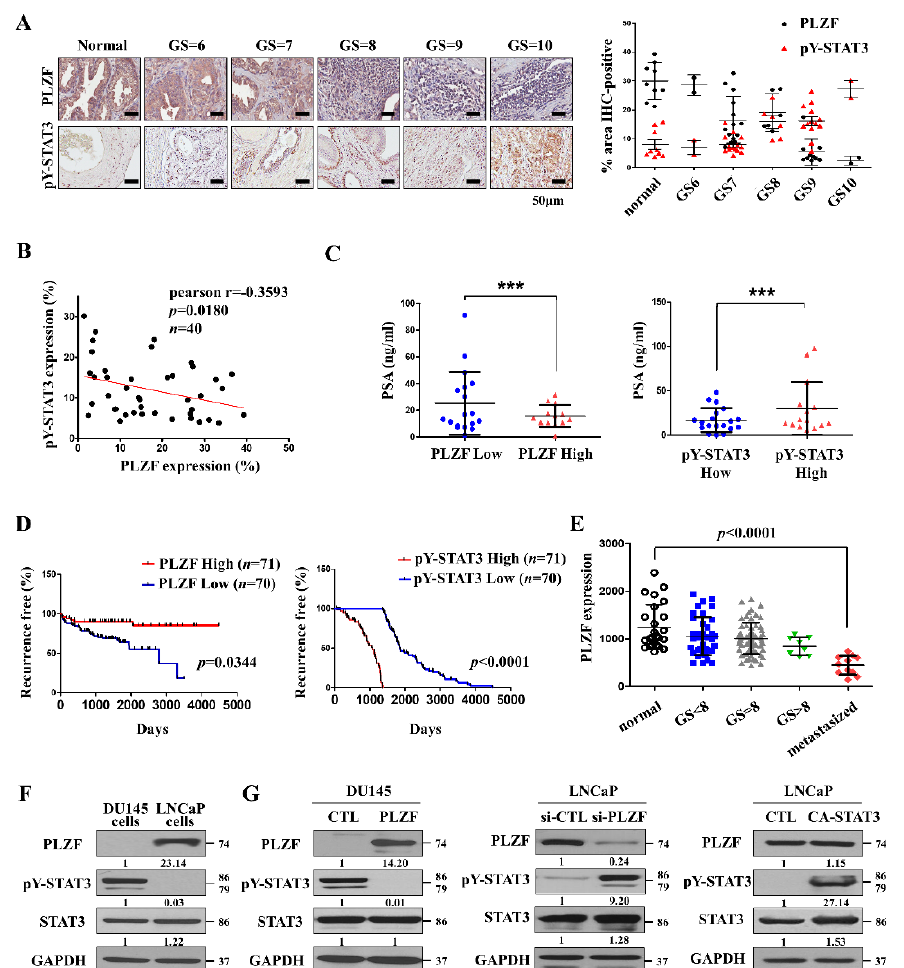
Figure 1. Promyelocytic leukemia zinc finger (PLZF) inhibits the activation of STAT3, which has an inverse correlation with PLZF. ( A ) IHC of PLZF, pY-STAT3 in tissue arrays of surrounding normal prostate tissues, and human prostate cancer specimens correlates with Gleason scores (GS). Quantification of PLZF-positive expression according to the GS in normal tissues adjacent to the benign tumors ( n = 9) and malignant tumors ( n = 40) (right). ( B ) Associations between expression of PLZF and pY-STAT3. Scatter plots showing the linear correlation determined by Pearson correlation coe ffi cient calculation of those genes that were statistically significant. Pearson correlation coe ffi cient r and p -values are given in each scatter plot. ( C ) PSA levels were measured according to the PLZF and pY-STAT3 protein levels, n = 40. ( D ) Kaplan–Meier recurrence-free survival analysis of prostate cancer patients according to PLZF (* p = 0.0344) and pY-STAT3 (* p < 0.0001) expression. ( E ) Quantification of PLZF mRNA expression according to the GS and metastasis in prostate cancer patients’ samples, *** p < 0.0001. ( F ) PLZF, pY-STAT3, STAT3, and GAPDH protein expression by Western blotting